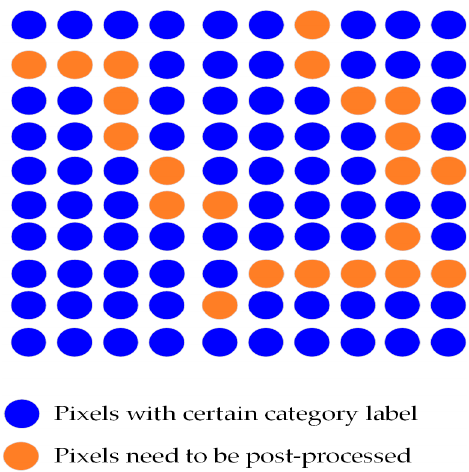
Figure 6. A description of the modeling progress for a partly connected conditional random field.